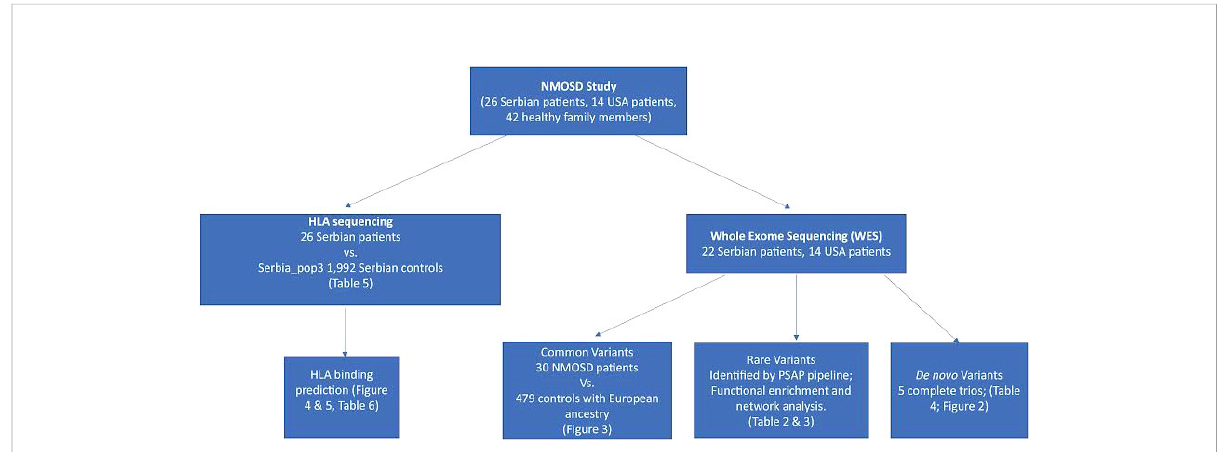
FIGURE 1 Analysis work fl ow. Our datasets were obtained from 26 Serbian patients and 14 US patients. For Serbian patients, we performed HLA sequencing and compared allele frequencies to 1,992 controls with the same ancestry. We then predicted the binding af fi nity of HLA proteins encoded by the alleles associated with NMOSD to AQP4 and MOG. Candidate mutations associated with NMOSD were identi fi ed in 36 patients through whole exome sequencing. Common, rare and de novo (when DNA from family members was available) potentially deleterious variants were identi fi ed.